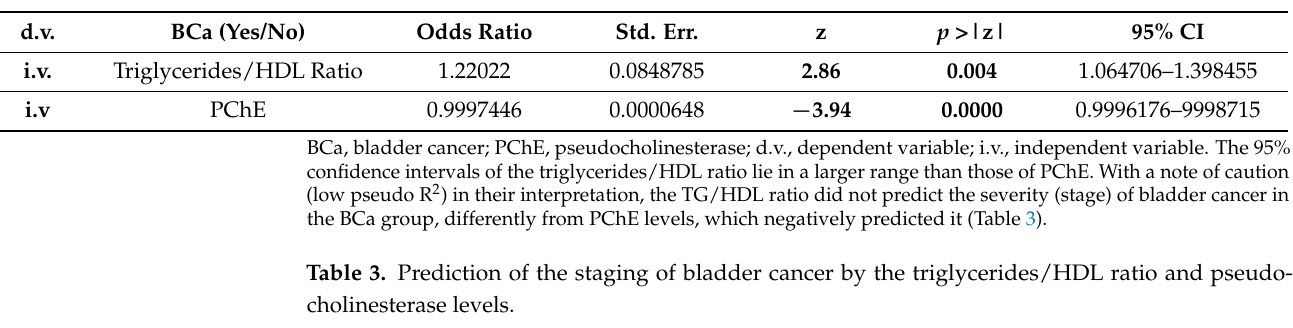
Table 2. Prediction of the presence of bladder cancer by the triglycerides/HDL ratio and pseudo- cholinesterase levels. Logistic regression: number of observations = 302, Pseudo R 2 = 0.0619.